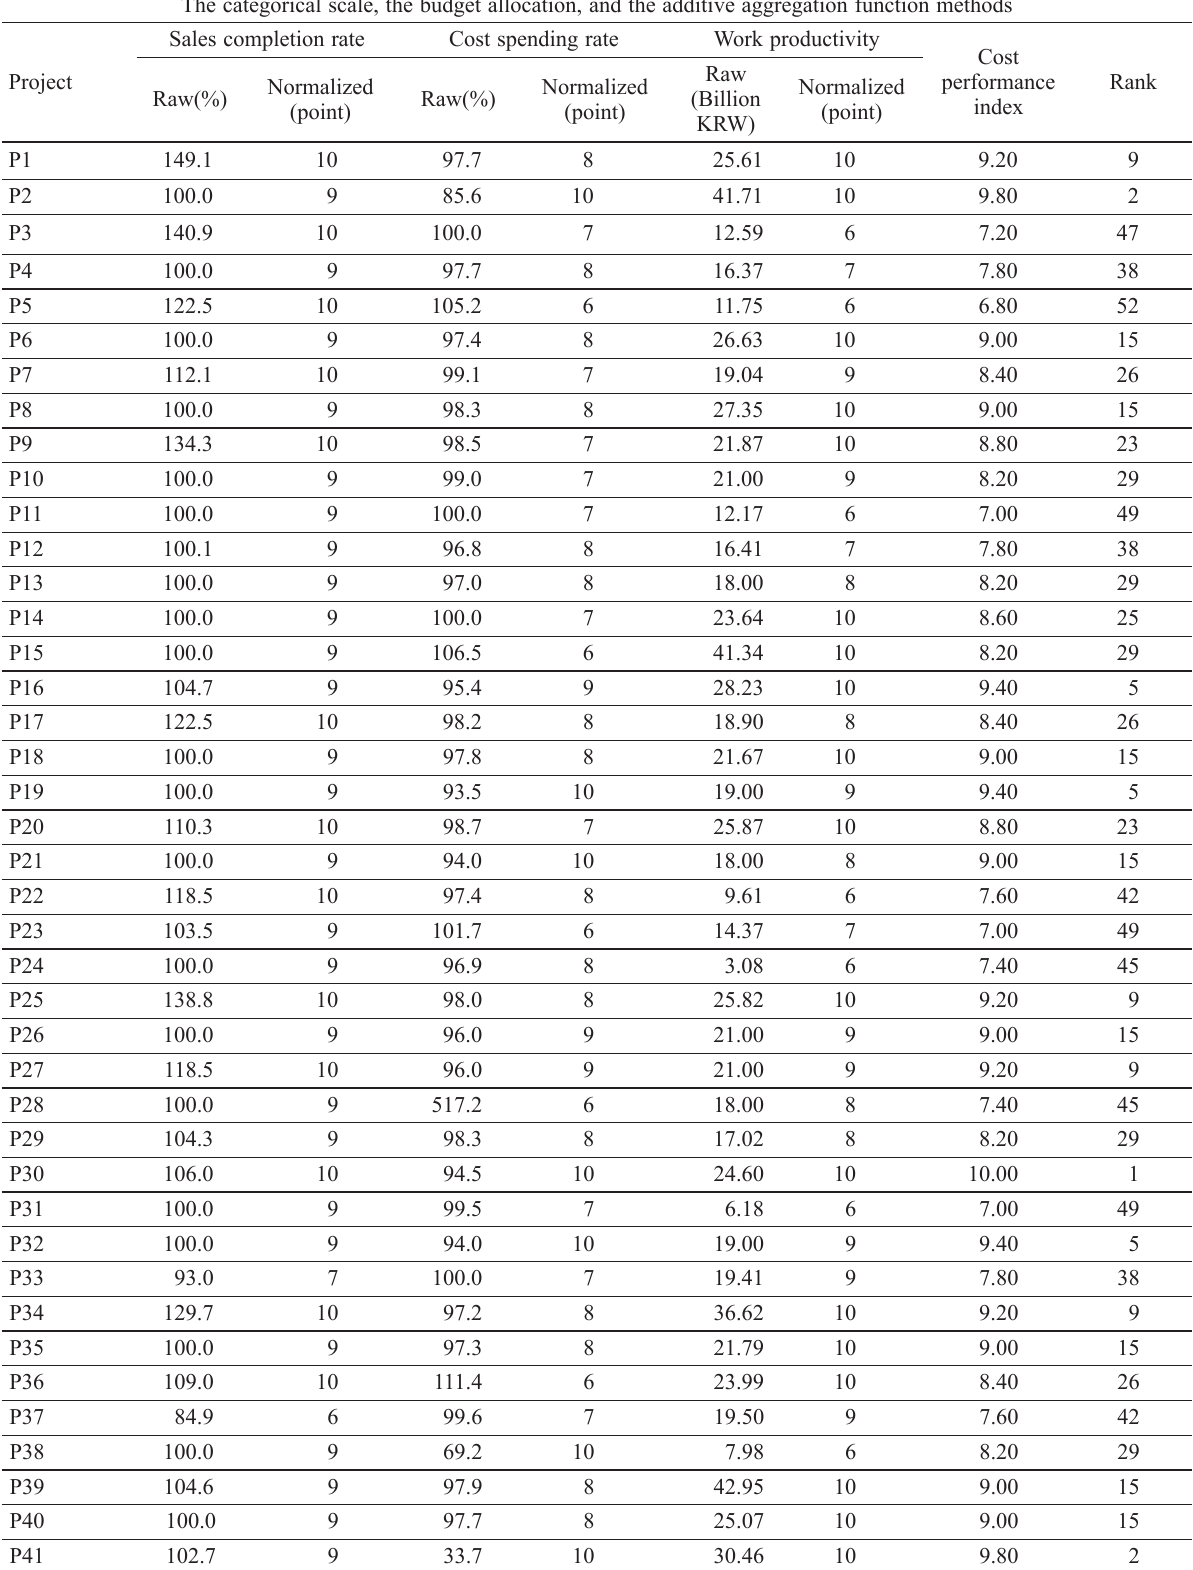
Table 1. The overall project performance evaluation based on the conventional methodology The categorical scale, the budget allocation, and the additive aggregation function methods